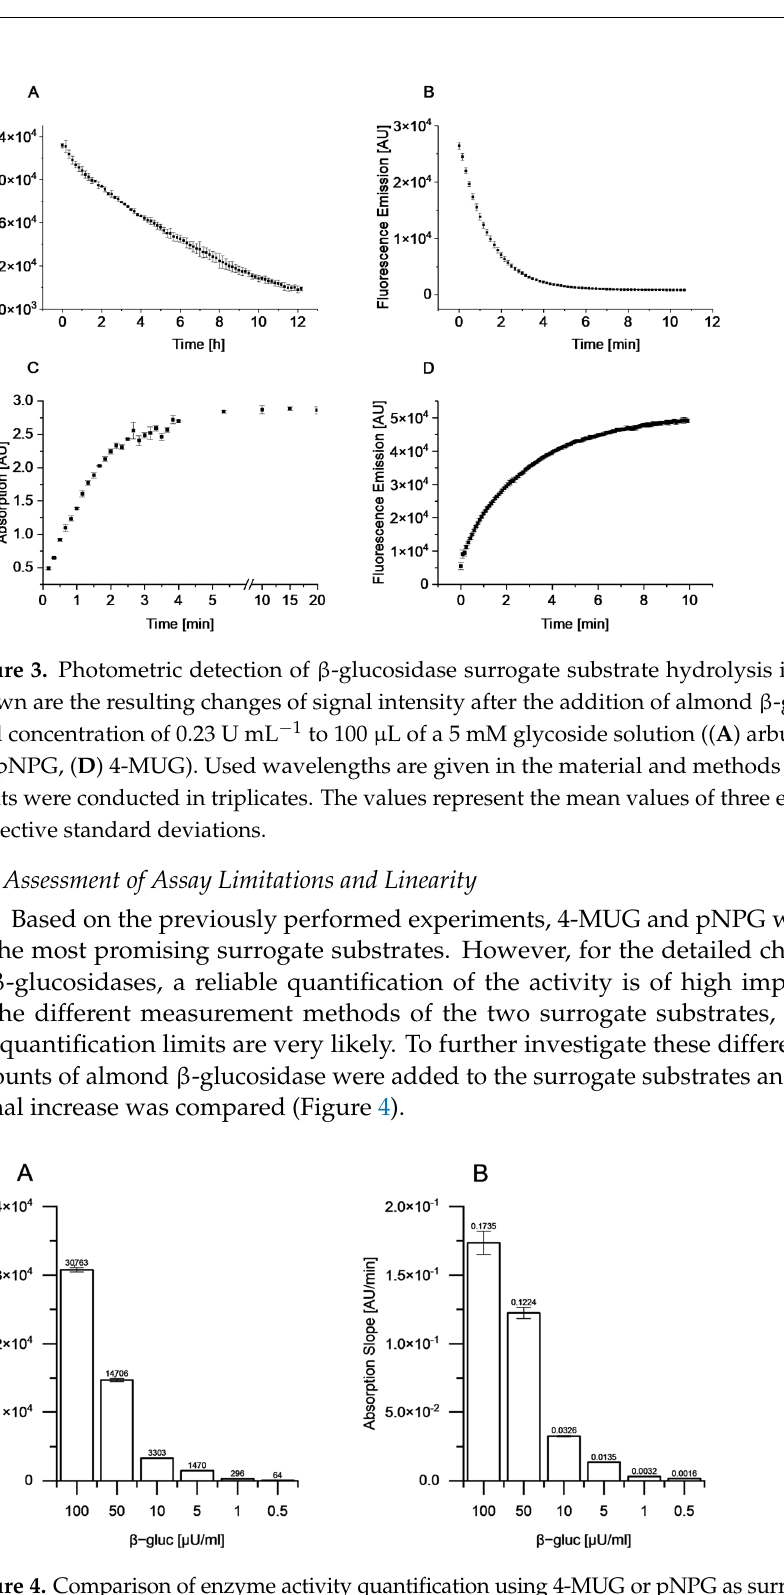
Figure 4. Comparison of enzyme activity quantification using 4-MUG or pNPG as surrogate sub- strates. The intensity increases of ( A ) 4-MU and ( B ) pNP signals after the addition of almond β -glucosidase to a final concentration of 100 µU mL − 1 , 50 µU mL − 1 , 10 µU mL − 1 , 5 µU mL − 1 , 1 µU mL − 1 and 0.5 µU mL − 1 are illustrated. The signal emission slopes were calculated from measurements for 5 min after the addition of almond β -glucosidase. Experiments were conducted in triplicates. The values represent the mean values of three experiments and respective standard deviations.